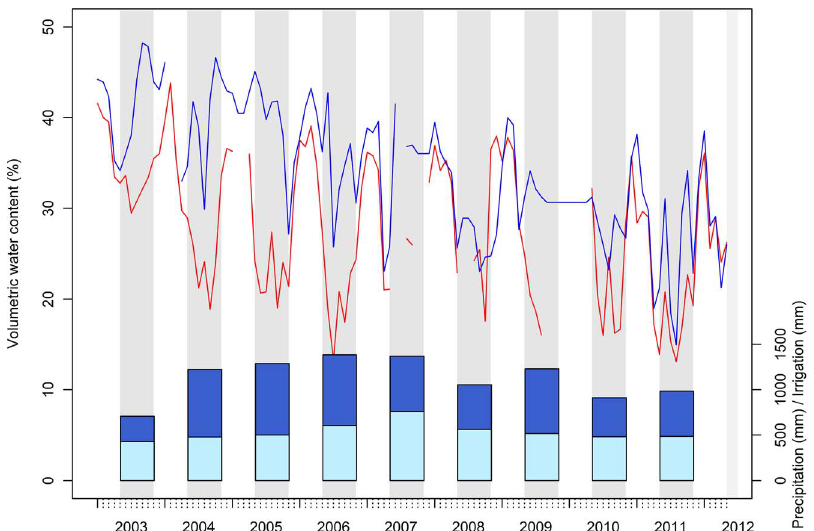
Figure 2. Monthly mean volumetric water content (%) of the irrigated (blue) and the control (red) plots over the experiment period (2003–2012). The annual precipitation (light blue bars) and the applied annual irrigation (blue bars) in millimetres are plotted on the second y-axis. Irrigation periods are indicated as grey bars.